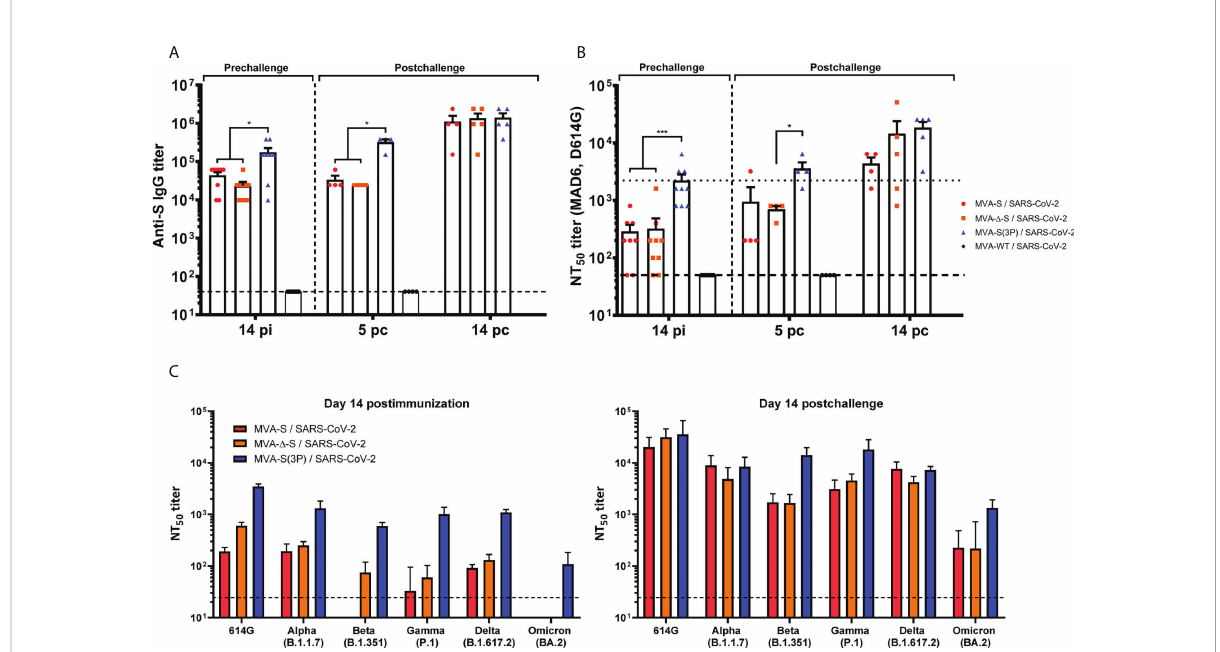
FIGURE 6 MVA-based vaccine candidates induced high levels of SARS-CoV-2-speci fi c humoral immune responses in vaccinated and challenged K18- hACE2 transgenic mice. (A) Titers of IgG antibodies speci fi c for the S protein (Wuhan strain). Determined by ELISA in individual mouse serum samples collected at day 14 postimmunization (pi) (prechallenge; n = 9/group) and at days 5 ( n = 4/group) and 14 ( n = 5/group) postchallenge (pc) from K18-hACE2 mice. Mean values and SEM are represented. The dashed line represents the limit of detection. (B) SARS-CoV-2 neutralizing antibody titers. NT 50 titers were evaluated in individual mouse serum samples collected at day 14 pi and at days 5 and 14 pc, using a live virus microneutralization assay (MAD6 strain, having D614G mutation). Mean NT 50 values and SEM are represented. The dotted line represents the limit of detection. (C) SARS-CoV-2 neutralizing antibody titers against SARS-CoV-2 VoC. NT 50 titers were evaluated in pooled mouse serum samples collected at days 14 pi (left) and 14 pc (right), using VSV-based pseudoparticles expressing the SARS-CoV-2 S protein of different VoC. Mean NT 50 values and 95% con fi dence intervals are represented. The dashed line represents the limit of detection. Student ’ s t - test: * p < 0.05; *** p <